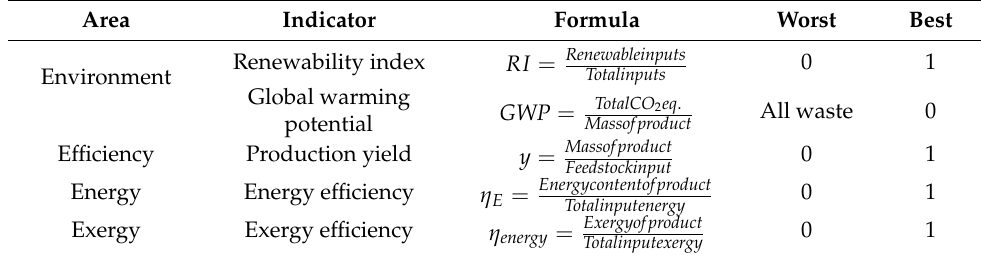
Table 3. Selected sustainability indicators and their best and worst